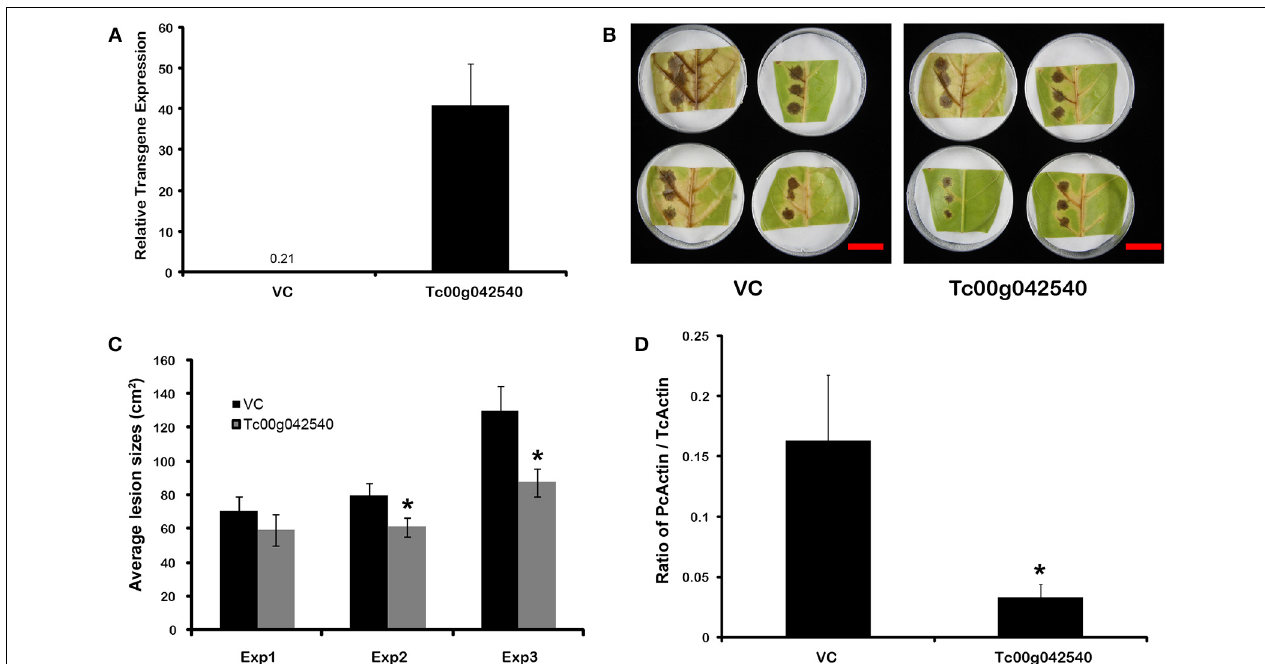
FIGURE 5 | Transient over-expression of endophyte inducible gene Tc00g042540 (a putative trypsin inhibitor) reduces Phytophthora capsici damage and virulence in T. cacao leaves. ∗ Significant differences for all analyses were determined by single factor ANOVA ( p < 0 . 05). (A) Tc00g042540 gene expression relative to TcACT ( Tc01g010900 ) at 2 days after Agrobacterium -mediated transformation (means ± SE). The basal expression of Tc00g042540 in Vector control (VC) tissues is only 0.21; (B) Representative images of the variation in lesions sized caused by P. capsici